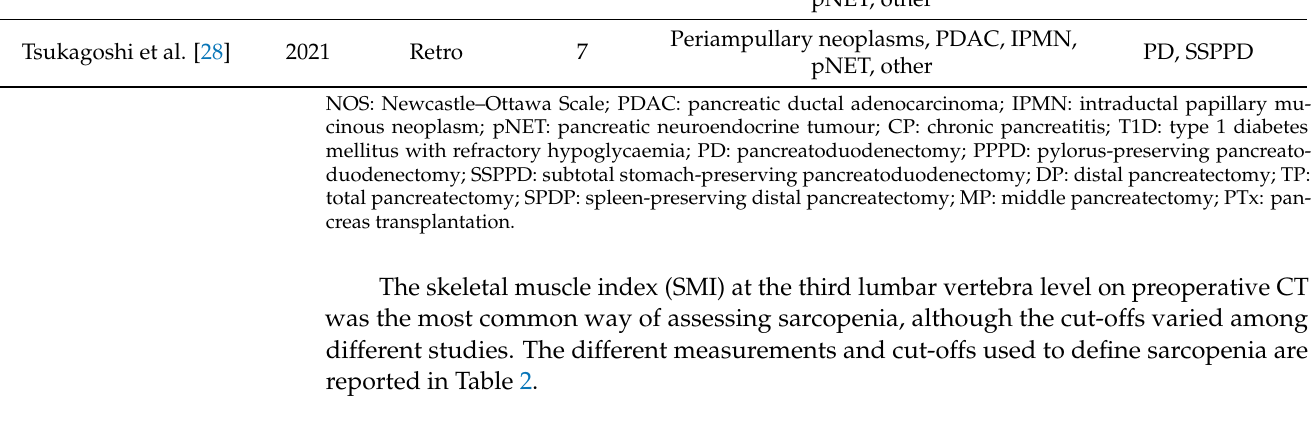
Table 2. Sarcopenia measures and cut-offs for each